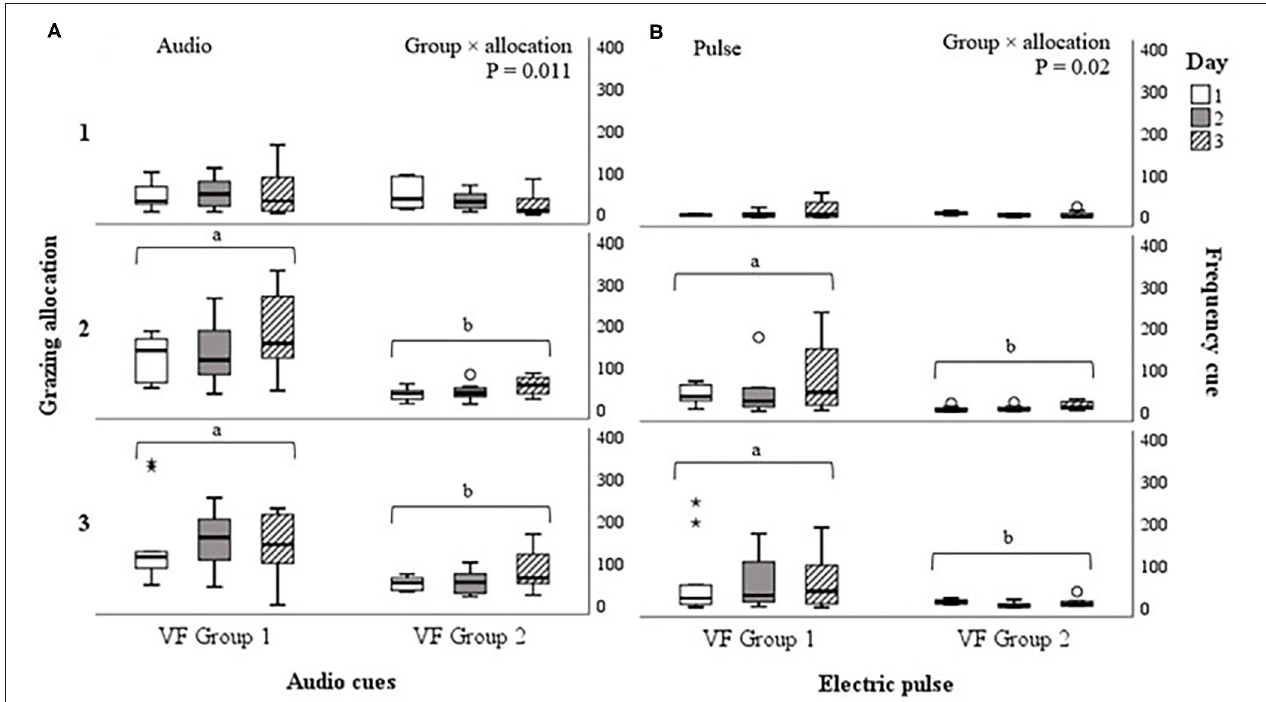
FIGURE 3 | Number of (A) audio cues and (B) electric pulses delivered to heifers in VF group 1 and VF group 2, at each day (1, 2 or 3) of each grazing allocation (1, 2 or 3). Raw data are presented. Least square means ± standard errors are presented in Supplementary Table 1 . Boxplots show the median and the first and third quartiles (25 and 75% of data), with whiskers extending to the lowest and highest values. Values > 1.5 × the interquartile range (IQR) are indicated by 0 and > 3 × the IQR are indicated by *. Different superscript letters ab show where means